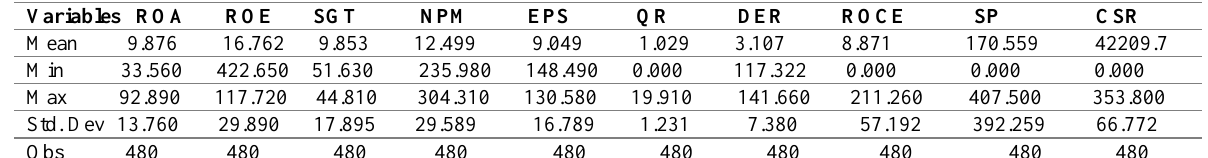
Table 1: Summary of descriptive statistics and correlation